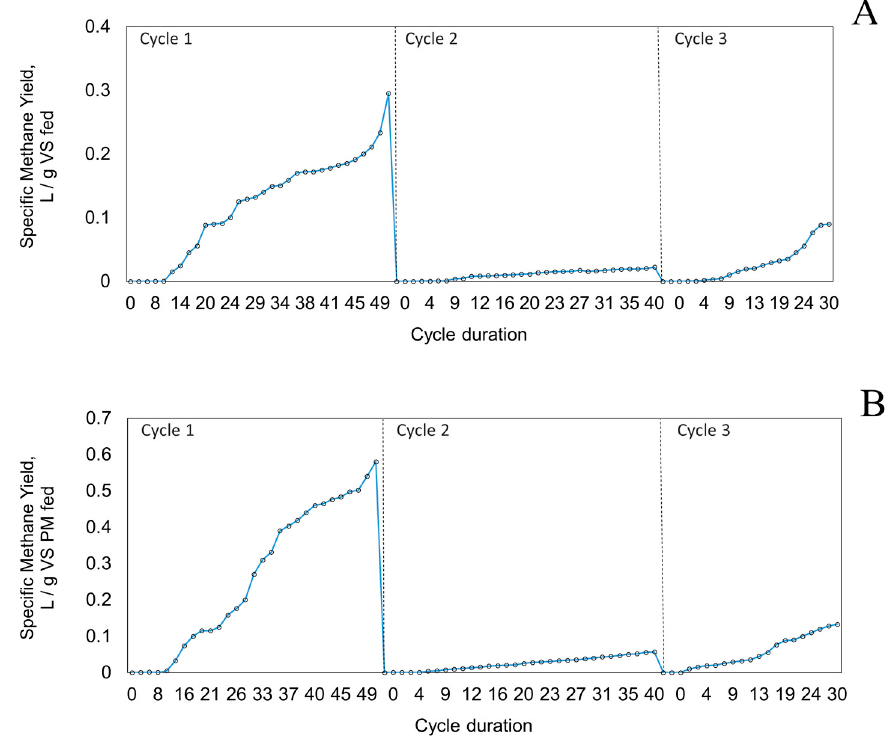
Figure 3. Specific methane yield profile for the static mode of operation in based on ( A ) volatile solids in feedstock mixture and ( B ) volatile solids in pig-manure solids. in feedstock mixture and ( B ) volatile solids in pig-manure